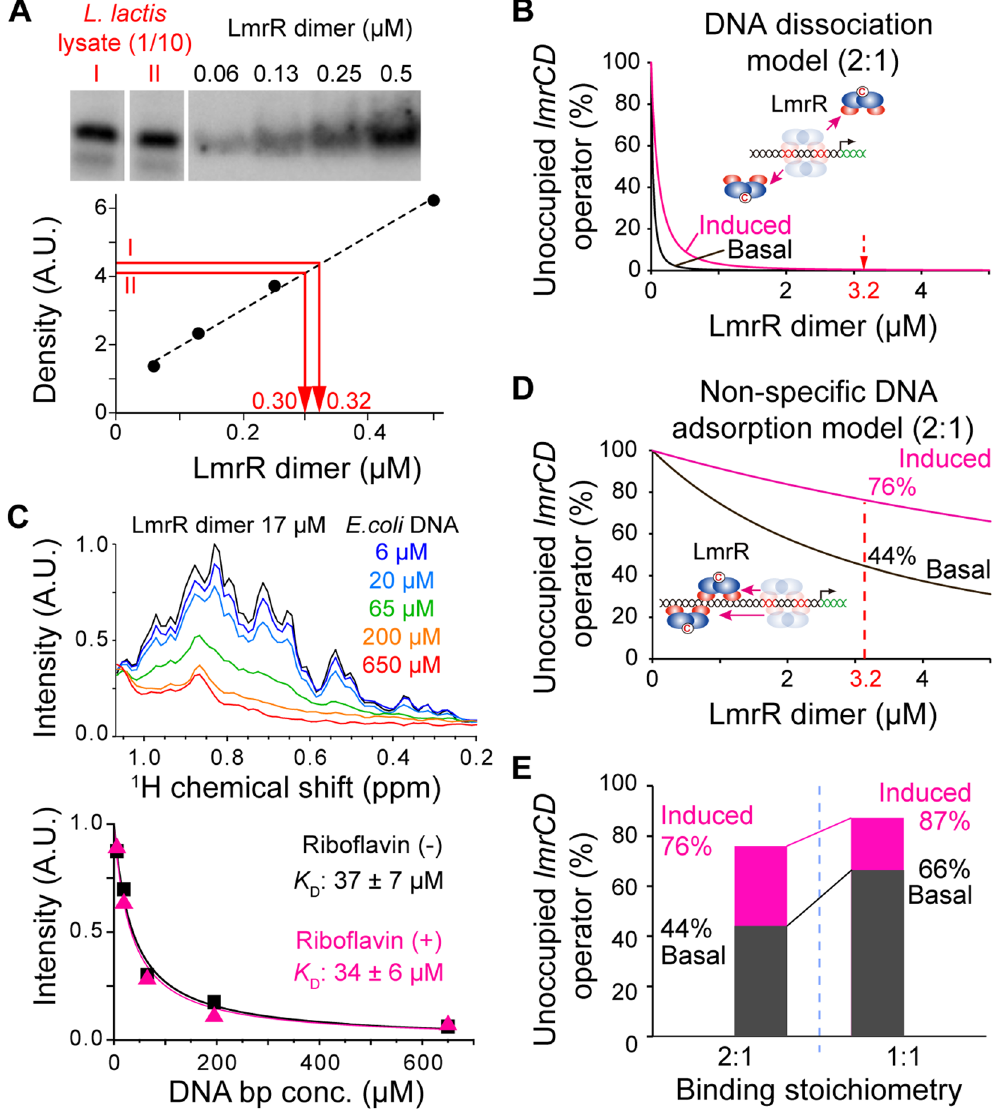
Figure 4. Transcriptional regulation of LmrR. ( A ) Western blot analysis of the intracellular LmrR concentration. The figure is originating from a single image but juxtaposed for clarification as indicated by the white bars. ( B ) Population of the unoccupied LmrCD operator in the DNA dissociation model. Black and magenta graphs represent the populations of the unoccupied lmrCD operator without and with riboflavin, respectively. ( C ) Determination of non-specific DNA absorbance, using the titration of the E . coli genomic DNA fragments against LmrR. Black and magenta graphs in the lower panel represent the intensities of LmrR resonances without and with riboflavin, respectively. ( D ) Population of the unoccupied lmrCD operator in the non-specific DNA adsorption model. Color codes are the same as in ( B ). ( E ) Population change of the unoccupied lmrCD operator in the non-specific DNA adsorption model with 2:1 (left) and 1:1 (right) binding stoichiometries. Color codes are the same as in ( B ). Data are representative of two independent